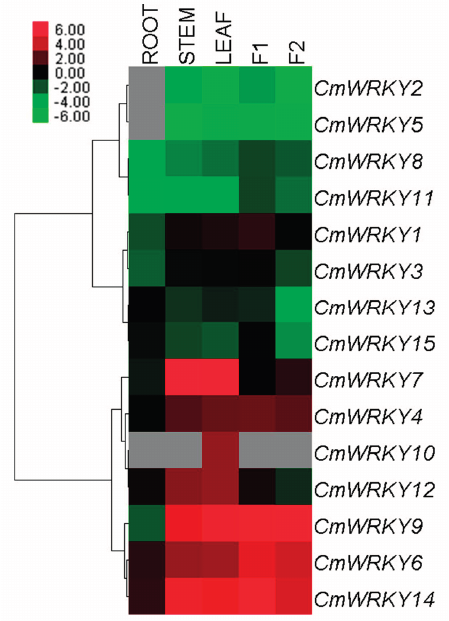
Figure 3. Differential transcription of CmWRKY genes. F1: tube florets, F2: ray florets at budding stage. Green indicates lower and red higher transcript abundance compared to the relevant control. Grey blocks indicate that transcription was not